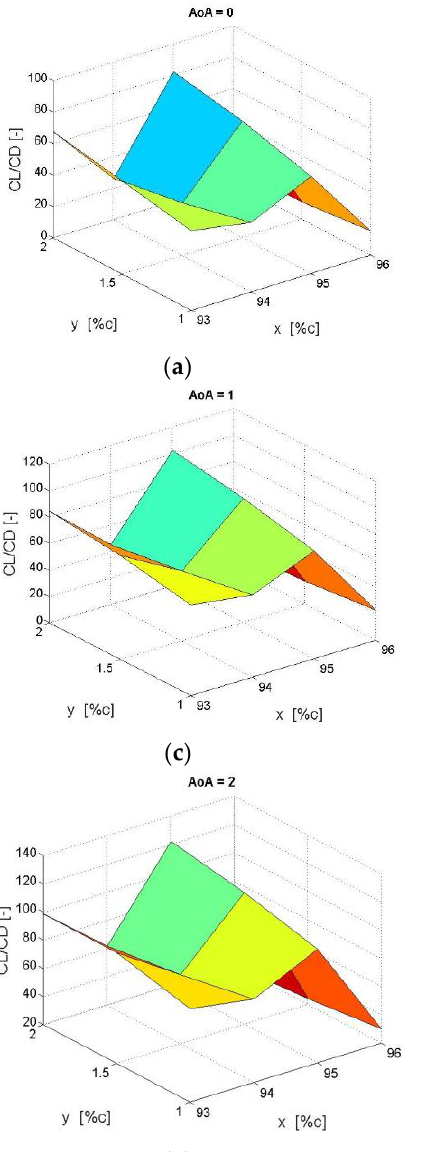
Figure A1. Lift-to-drag ratio of the S810 airfoil with GFs for each AoA. CFD results are denoted by * and the red line represents the POD approximation. Each sub-plot corresponds to an angle of attack AoA of the airfoil.